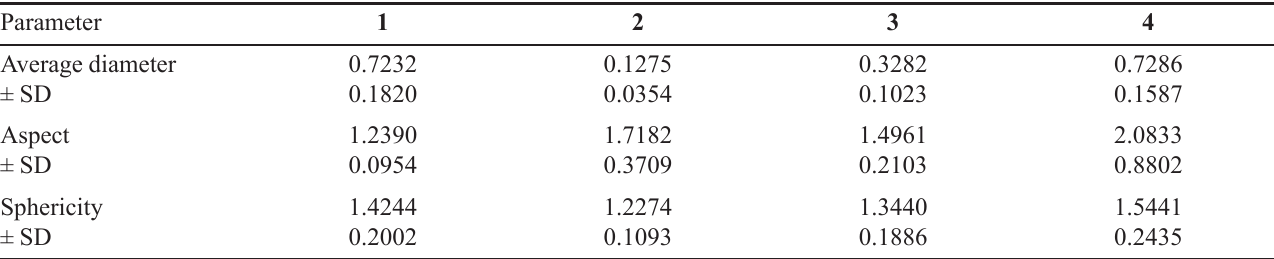
TABLE III - Values for average diameter, aspect and sphericity obtained after editing images using the Image Pro Plus ® software program, for the formulations containing PVP (1), PEG (2), HPMC (3) and MC (4). SD = standard deviation